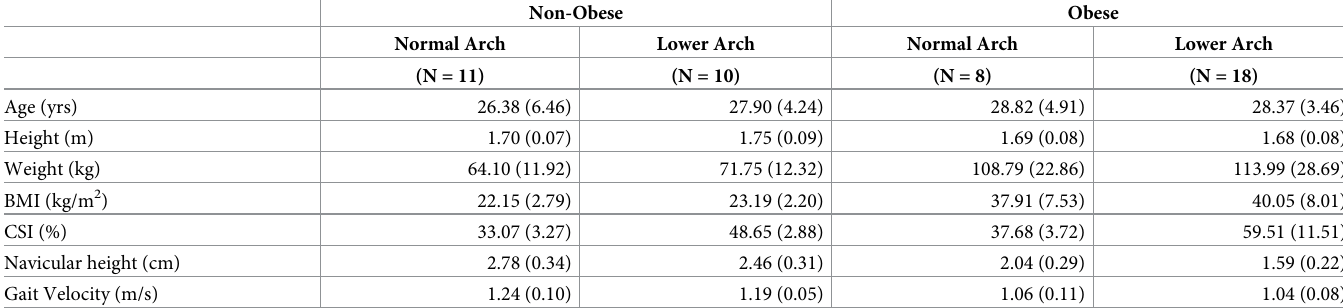
Table 1. Demographics and anthropometric information. Means are listed with standard deviations in